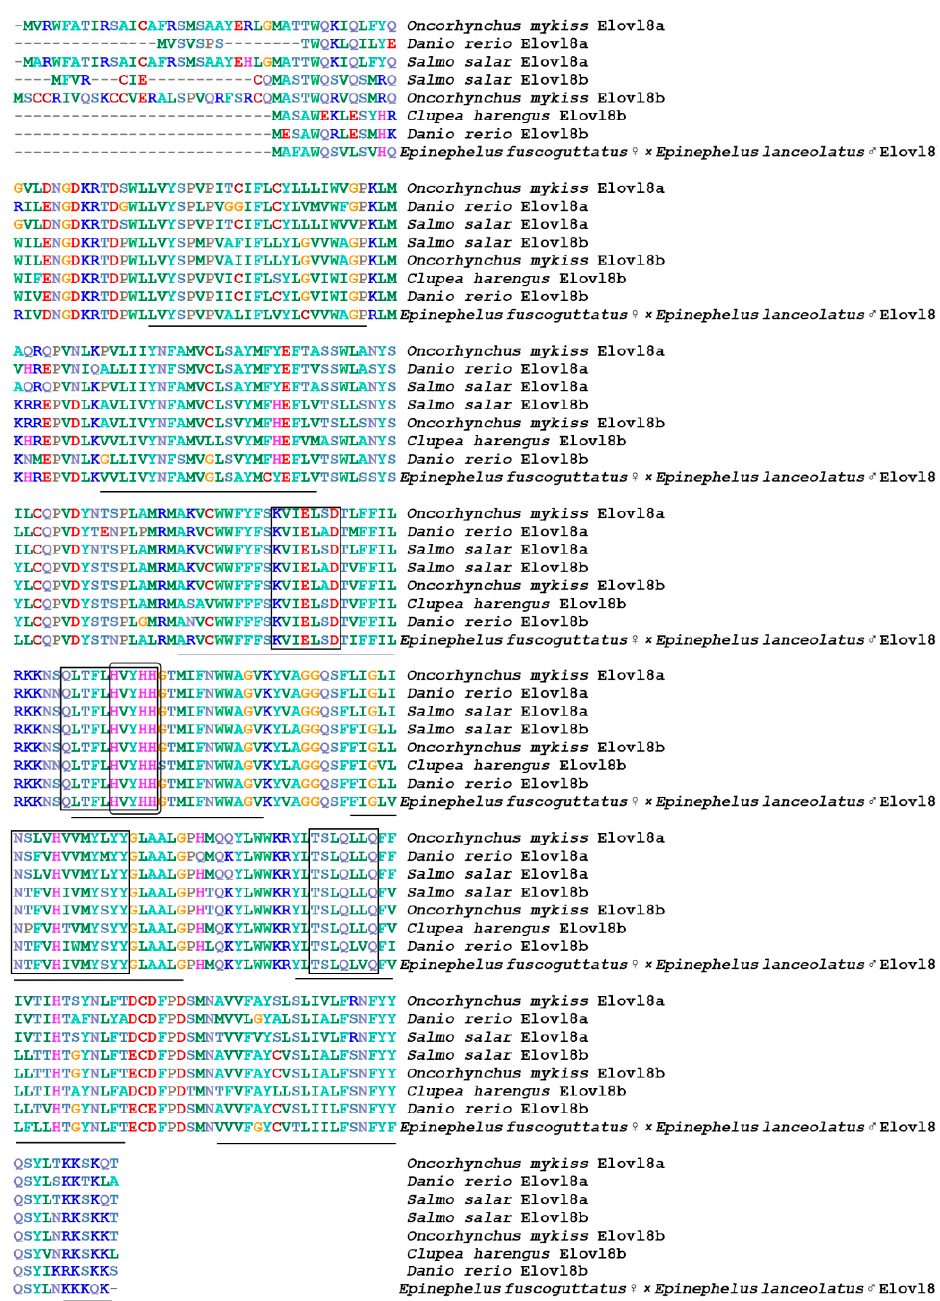
Figure 2. Multiple amino acids sequence alignment of Elovl8 from different species. The transmem- brane region of amino acids is represented by a straight line; the conserved motif is marked with a square; the histidine box is marked with an ellipse, and endoplasmic reticulum signal is marked with a double line.